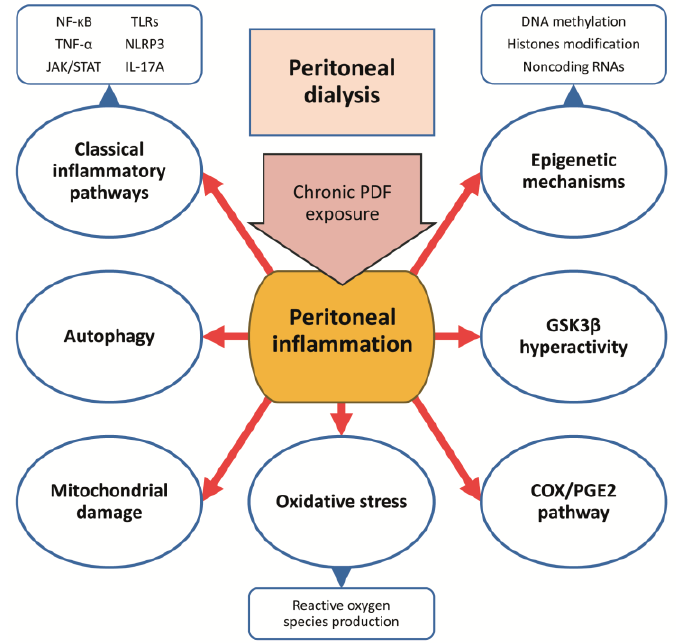
Figure 3. Cellular pathways and mechanisms involved in the inflammatory response to chronic PDF exposure during PD .